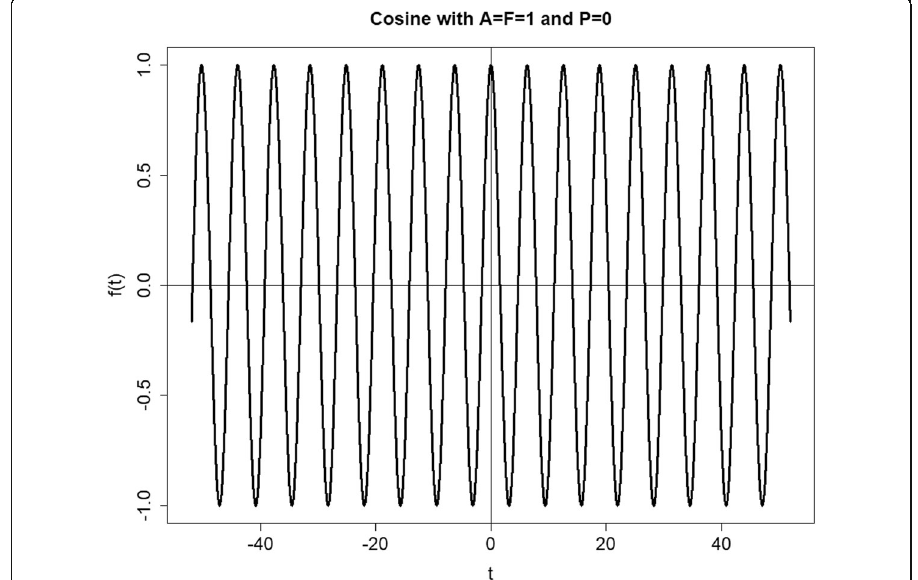
Fig. 11 Cosine function with amplitude 1 and period 2